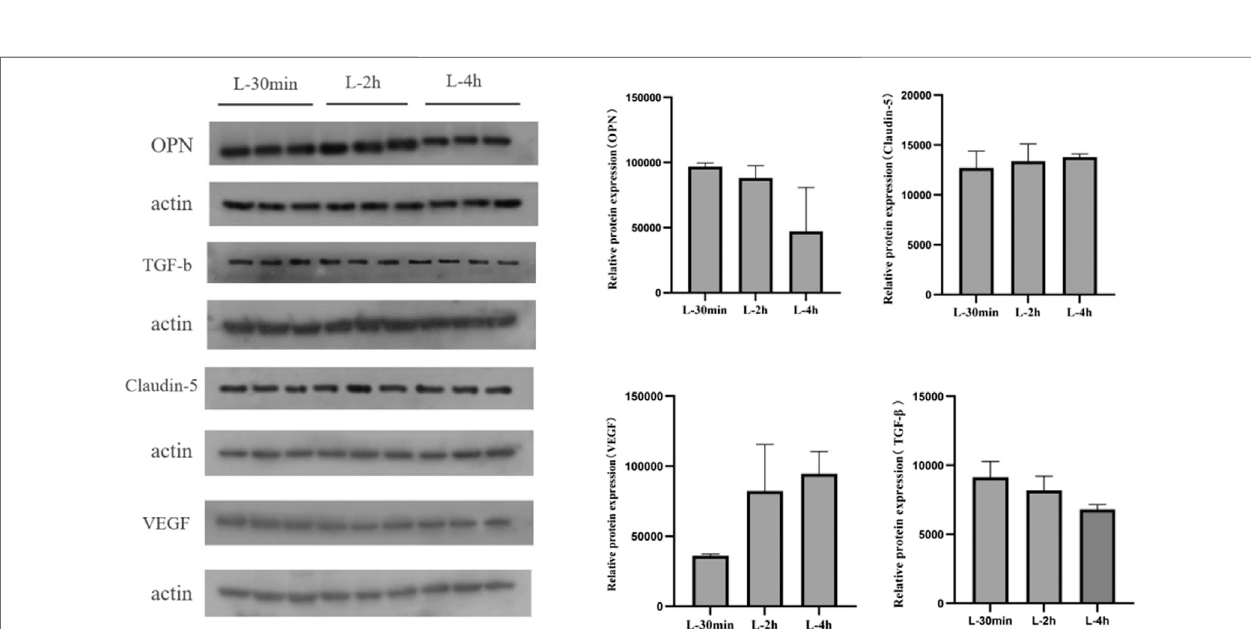
FIGURE 6 | Expression of key proteins in blood-brain barrier after lorlatinib administration.